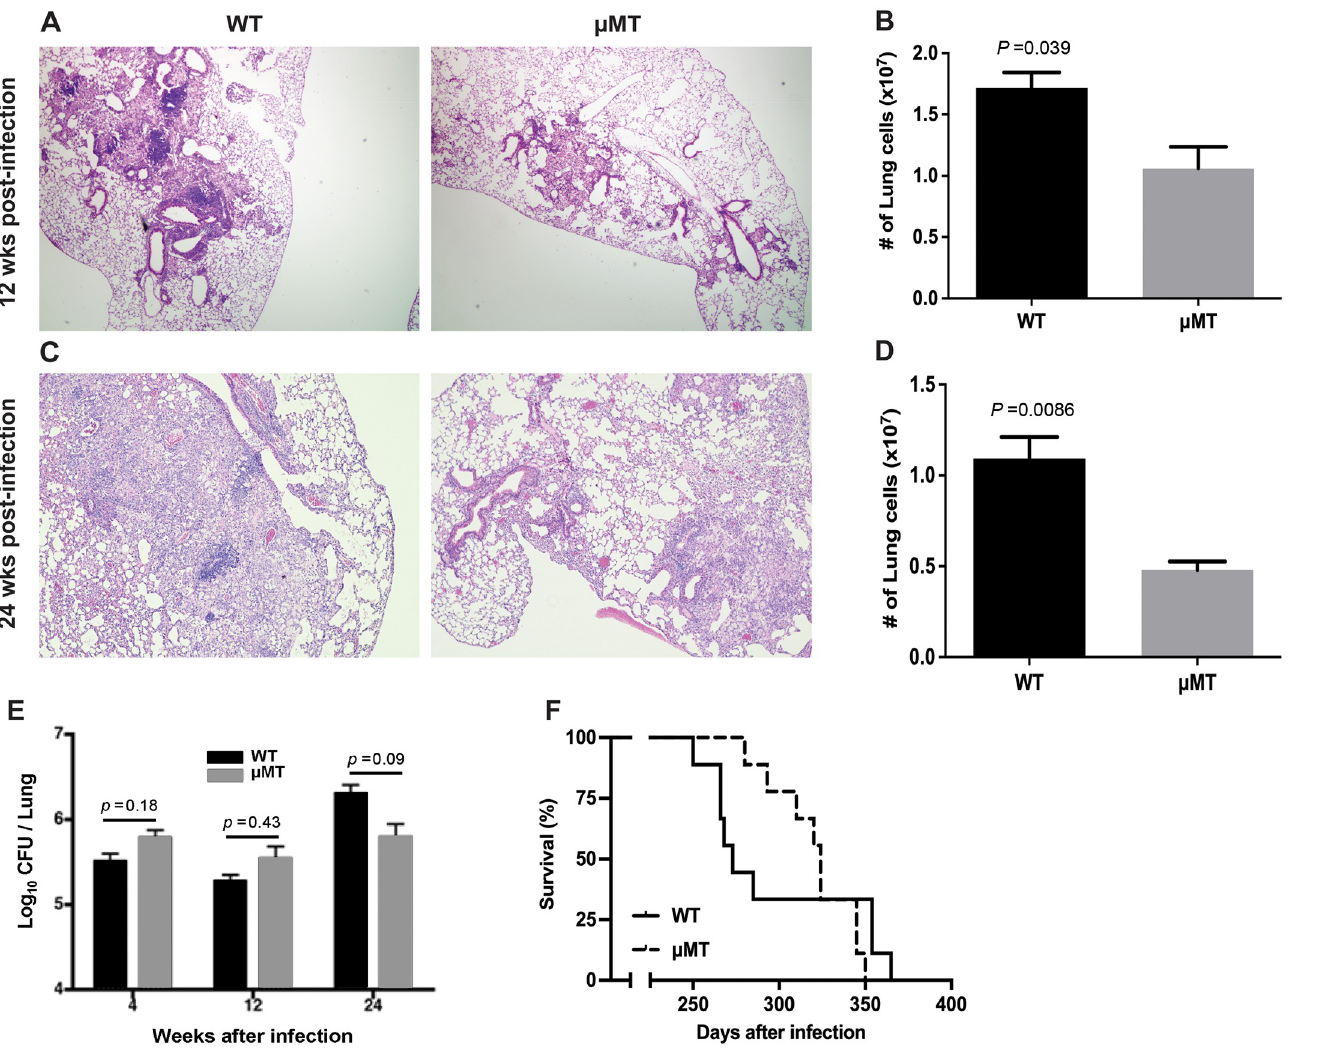
Fig 1. B cell-deficient μ MT mice exhibit diminished lung infiltrates relative to WT C56BL/6’s in chronic TB. WT and B cell-deficient μ MT mice were aerogenically infected with 100 CFU of M . tuberculosis Erdman and tissues analyzed by examination of H&E-stained lung sections at 12 weeks (A) and 24 weeks (C)